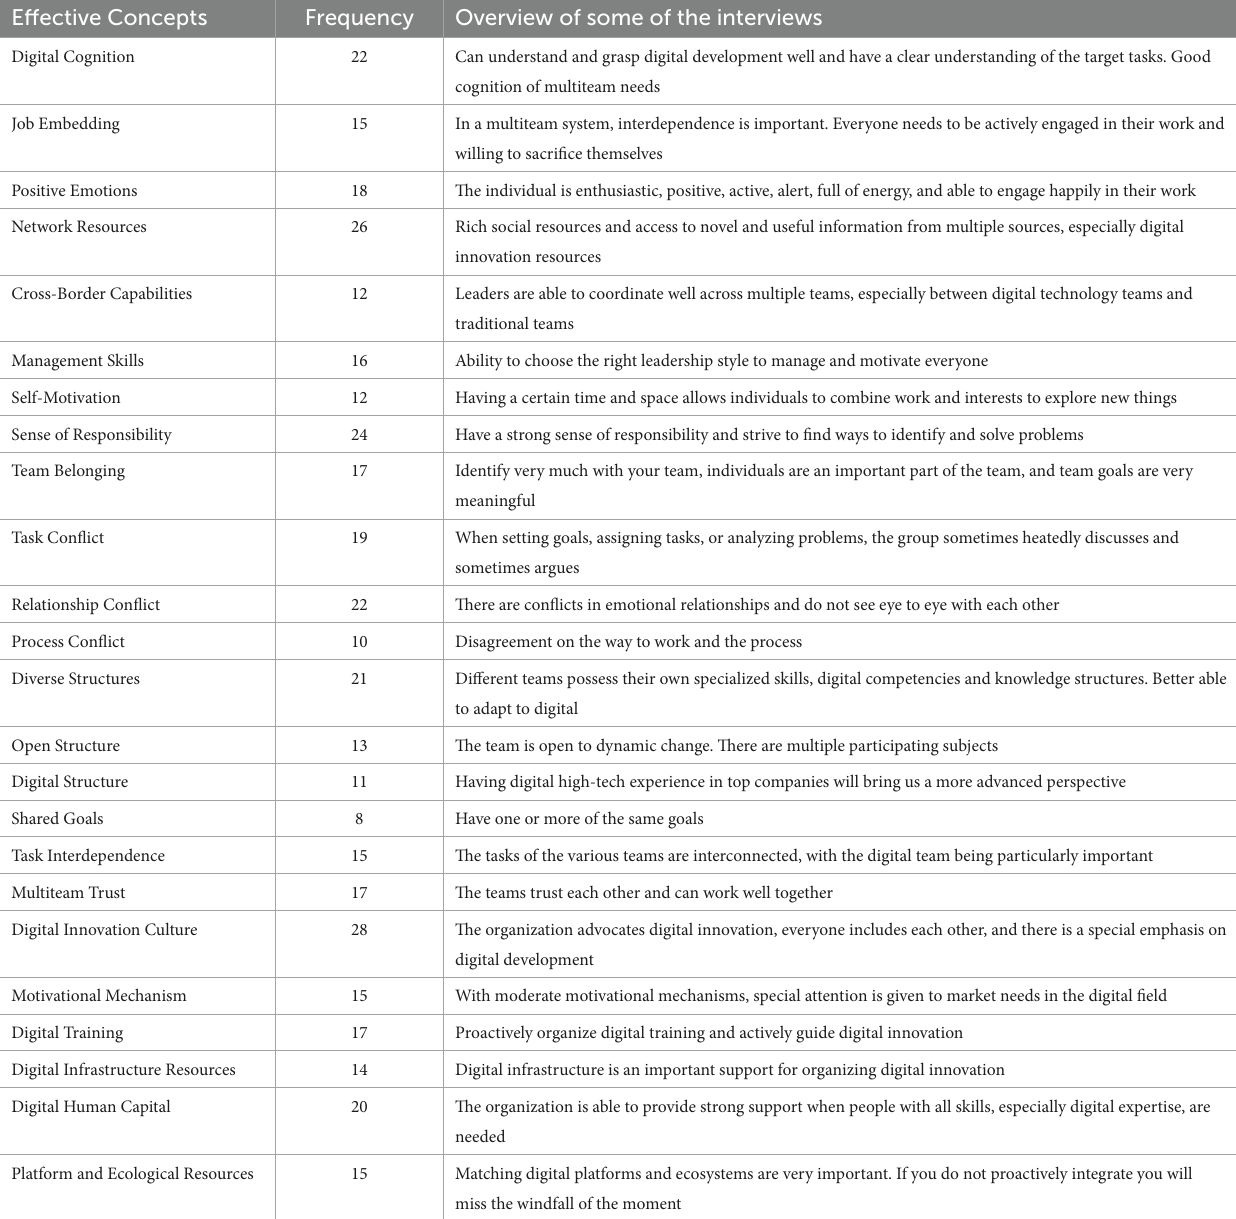
TABLE 2 Coding database of some interview contents in the transition